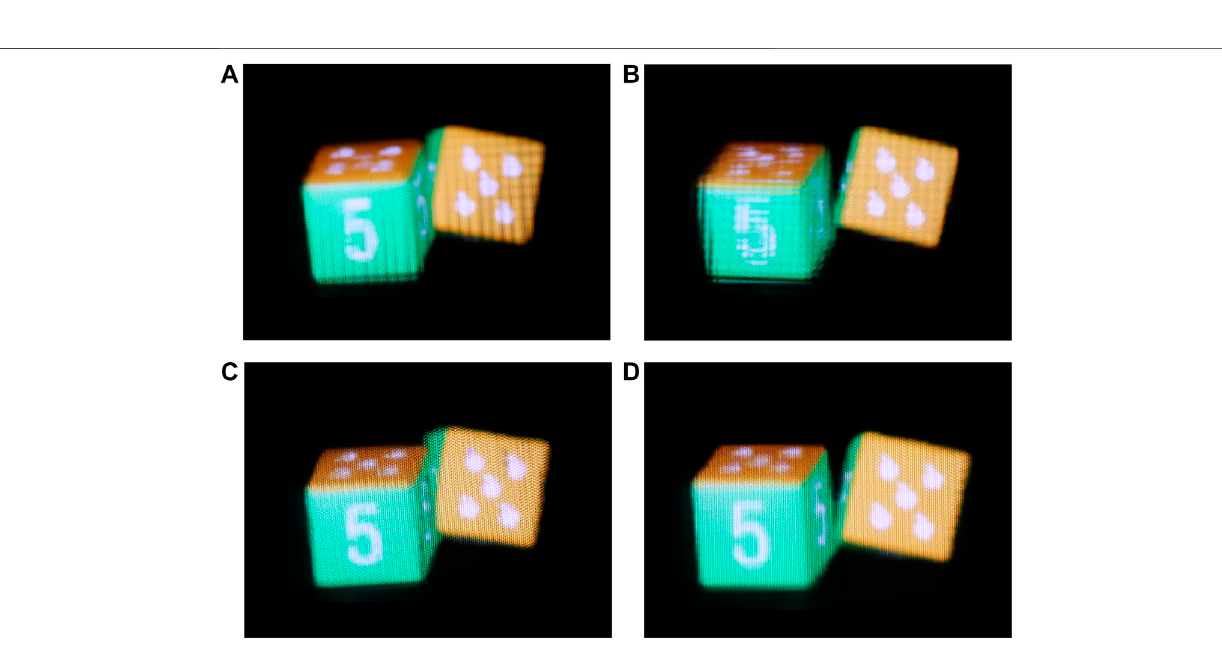
Frontiers in Physics |